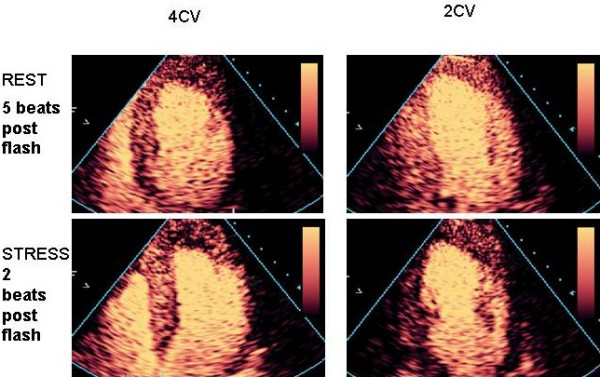
On the 4CV, an apical and a subendocardial basal infero-septal defect are evident 2 beats post stress. The lateral wall is affected by artefact. On the 2CV, there is hypoperfusion of the inferior wall and subendocardial apical defect on the post stress images. This is consistent with multi-vessel disease.